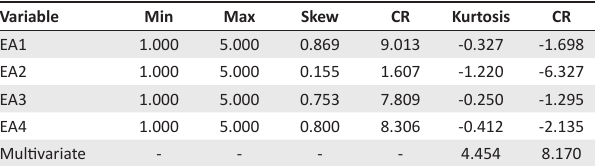
TABLE 2: Assessment of normality (Group number